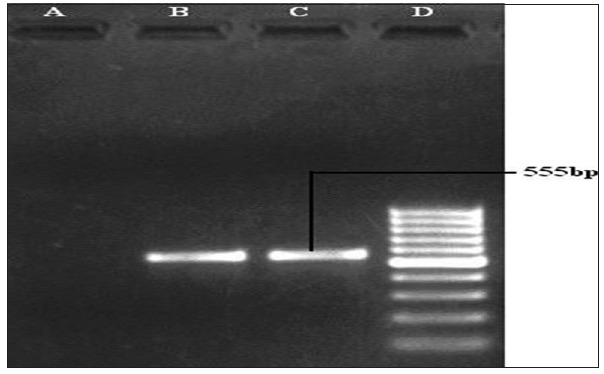
Figure-8: Polymerase chain reaction for the detection of nanB gene (555 bp) of Pasteurella multocida. Lane A: Samples negative for nanB gene. Lane B and C: Samples positive for nanB gene. Lane D: 100 bp DNA Ladder.